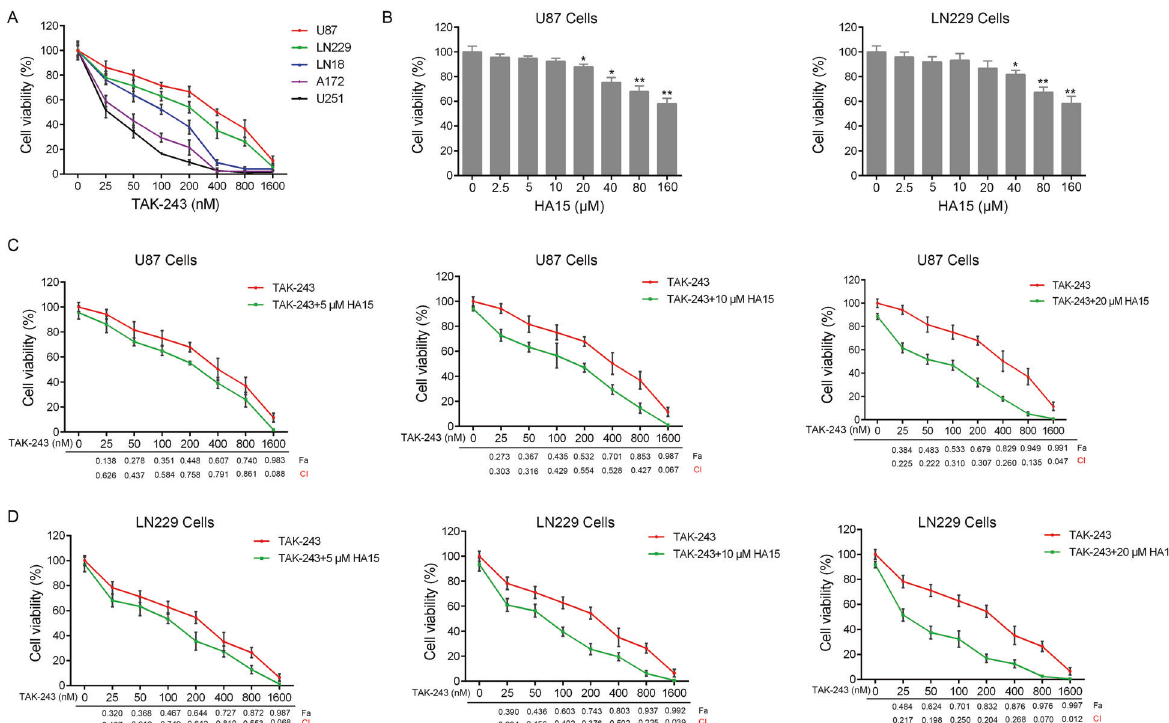
Fig. 1 HA15 combined with TAK-243 synergistically inhibits GBM cell viability. A GBM cells were treated by indicated concentrations of TAK-243 for 72 h. The cell viability was examined by CCK-8 assay. B U87 and LN229 cells were incubated with indicated concentrations of HA15 for 72 h, respectively. Cell viability was assessed by CCK-8 assay. C , D U87 ( C ) and LN229 ( D ) cells were treated by TAK-243 combined with different concentrations of HA15 for 72 h. The cell viability was examined by CCK-8 assay. Combination index (CI) of the combination of HA15 and TAK-243 in U87 and LN229 cells was calculated by the Chou-Talalay